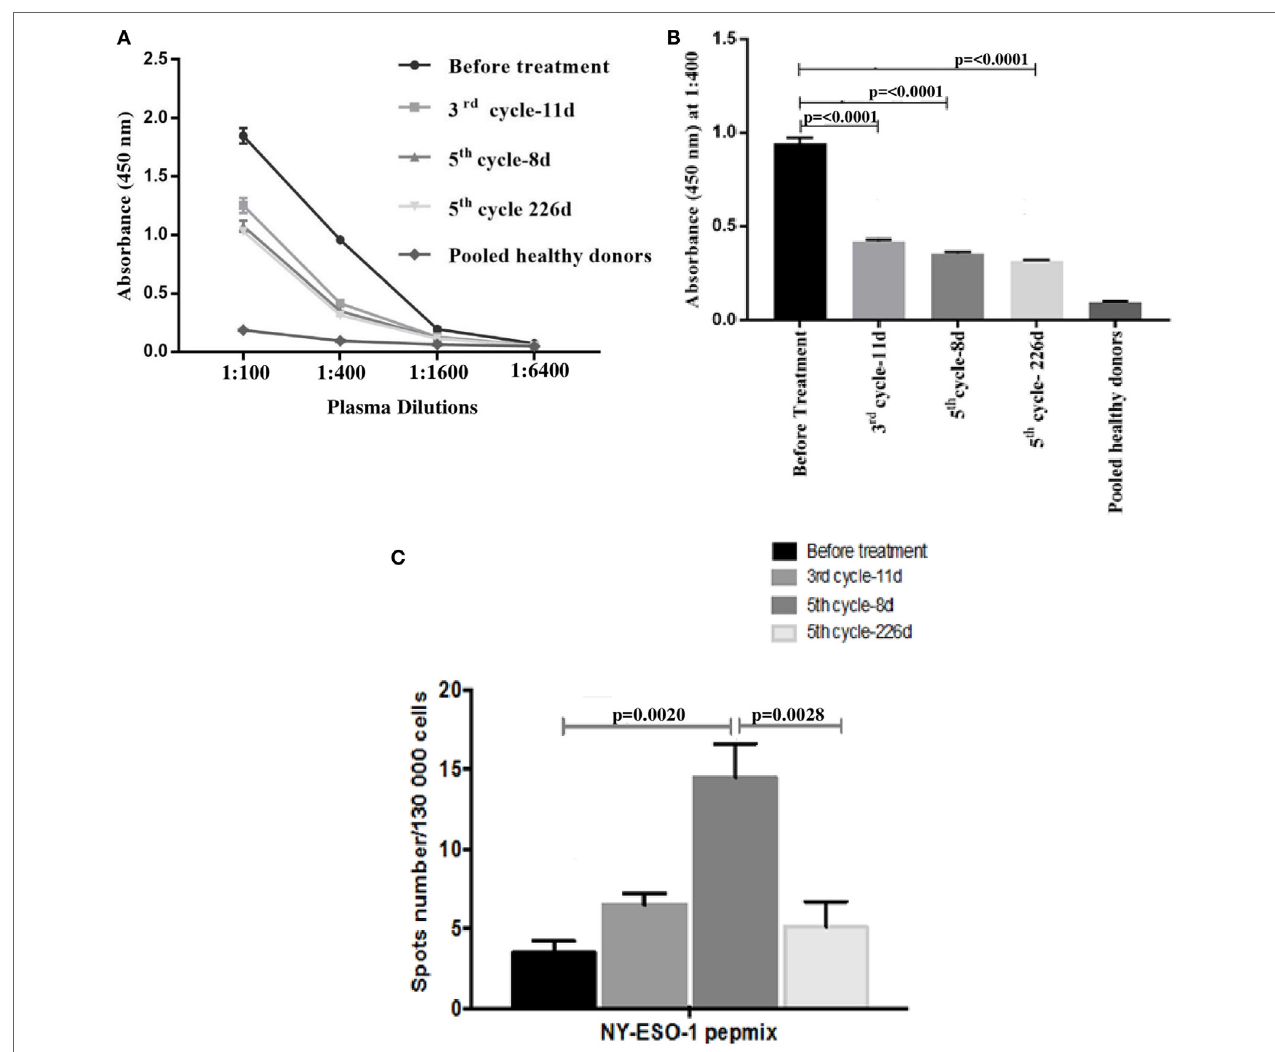
FIgURe 2 | Antibody response to the NY-ESO-1 antigen as measured in the plasma by enzyme-linked immunosorbent assay (ELISA). (a) The results are expressed as the mean OD value and error bars indicate the SD for the triplicate values in each dilution. Out of the four different plasma dilutions tested (1:100, 1:400, 1:1,600, and 1:6,400), 1:100 and 1:400 were found to be the optimum dilutions to differentiate the anti-NY-ESO-1 antibody level before and after nivolumab treatment. (B) Bar graph represents the mean OD values were measured at 1:400 dilution. Each ELISA experiment was repeated six times and the shown data corresponds to one representative experiment. (C) Enzyme-linked immunospot (ELISPOT) assay for interferon-gamma production to investigate T cell response to the NY-ESO-1 antigen in patient’s peripheral blood mononuclear cells against NY-ESO-1 overlapping peptides (PepMix). The assay was repeated three times and the shown data corresponds to one representative experiment. Statistical analysis for ELISA and ELISPOT were performed using non-parametric unpaired ANOVA followed by multiple comparison Dunnet’s test and p values < 0.05 were considered statistically